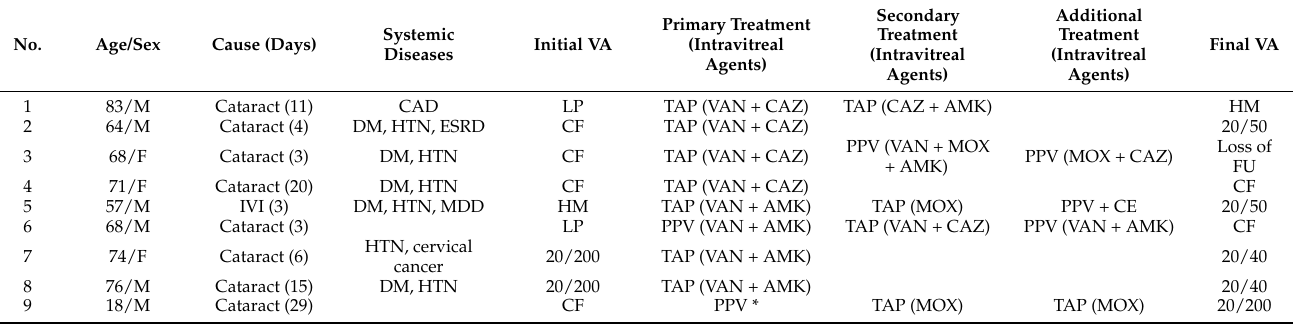
Table 1. Demographics, Clinical Characteristics, Management, and Visual Outcomes of Patients with Stenotrophomonas maltophilia Endophthalmitis.